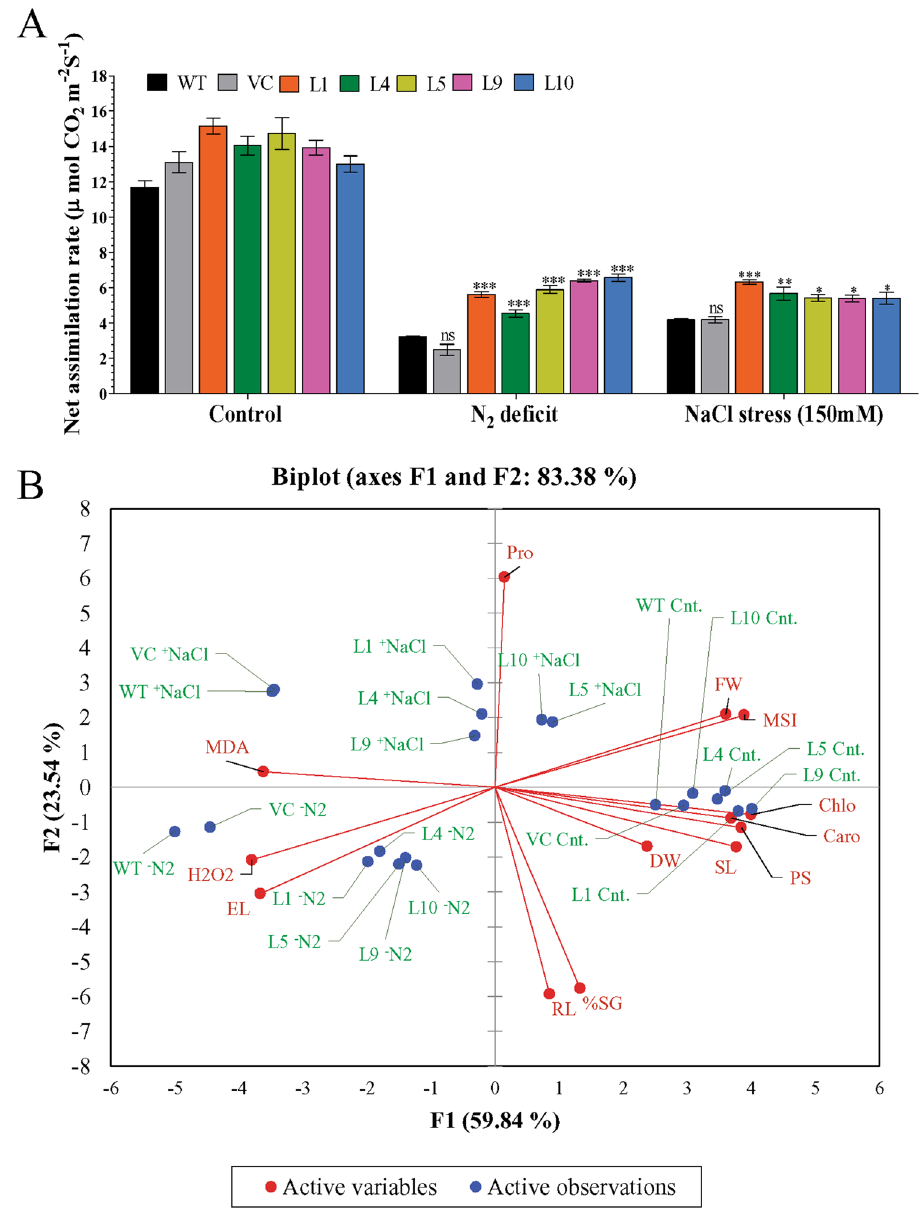
represent means ± standard error, and ‘*’, ‘**’ and ‘***’ designates for significant differences at P < 0.05, P < 0.01 and P < 0.001,